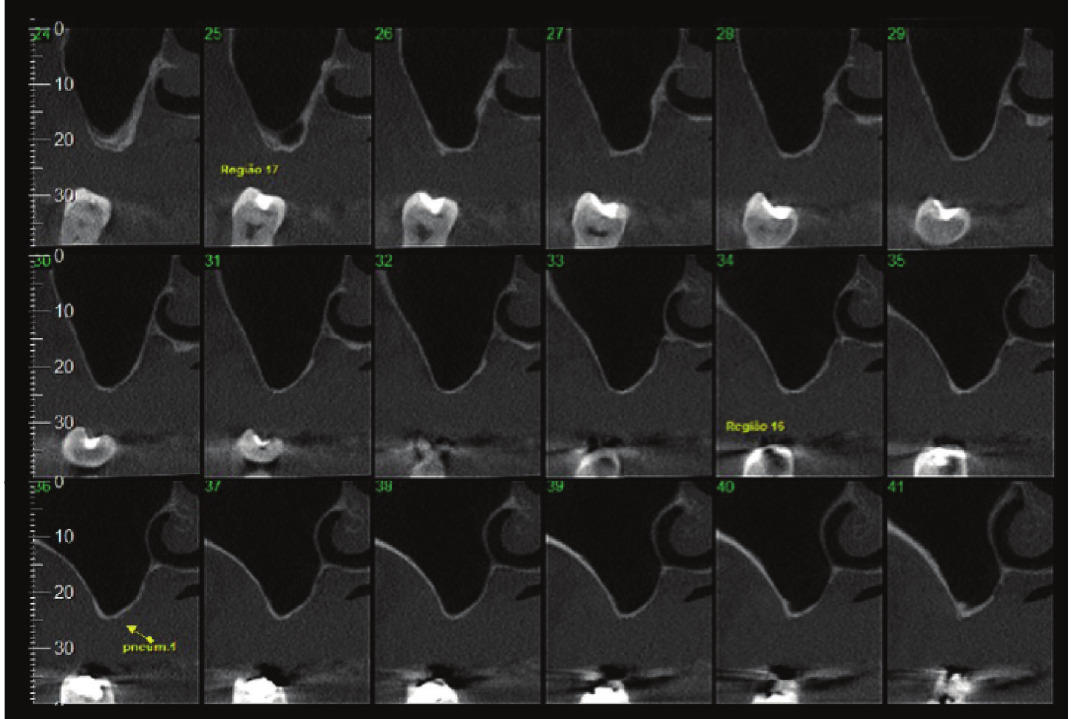
Figure 1: Cone-beam computed tomography scans of the posterior maxillary